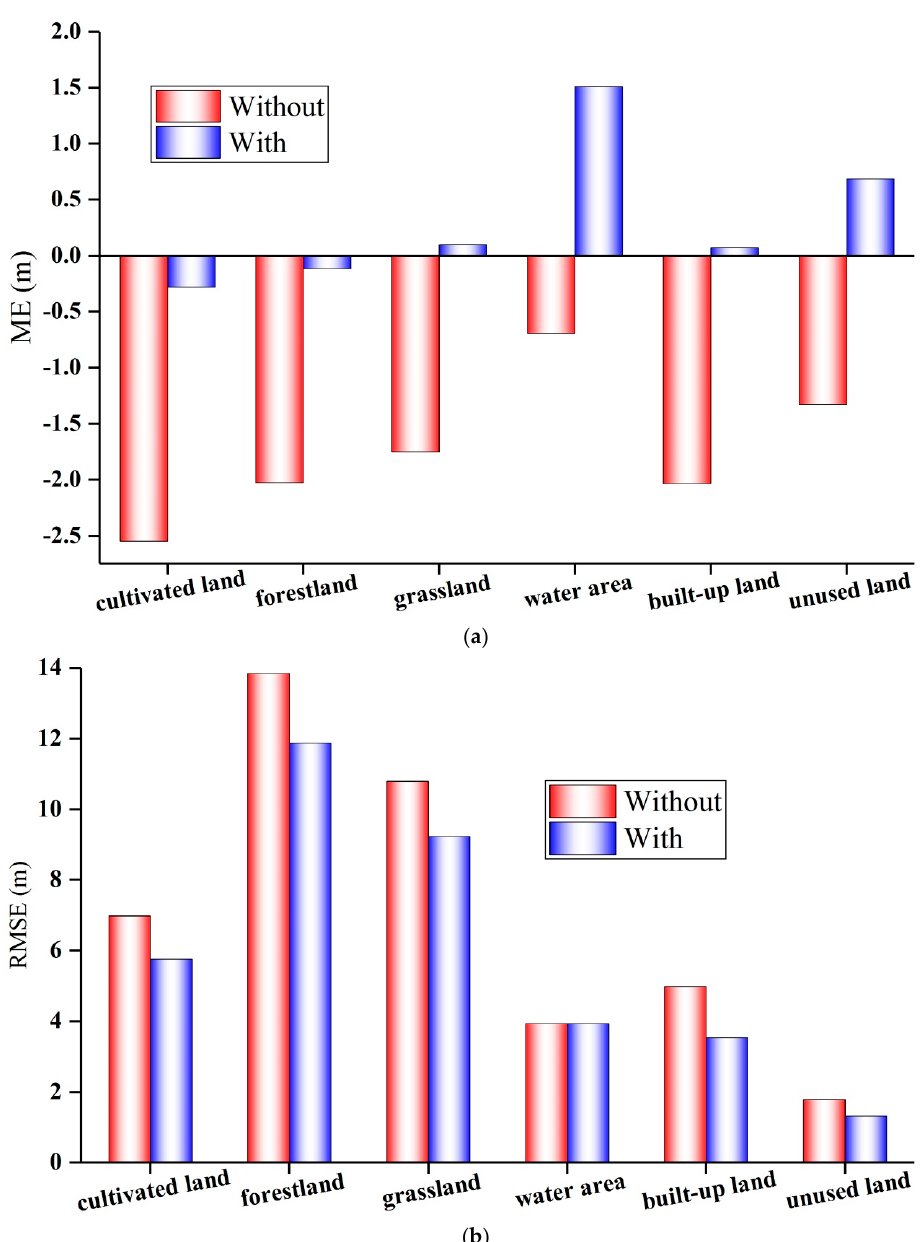
Figure 10. ( a ) ME and ( b ) RMSE of SRTM3 DEM under different land uses without and with data coregistration (m).